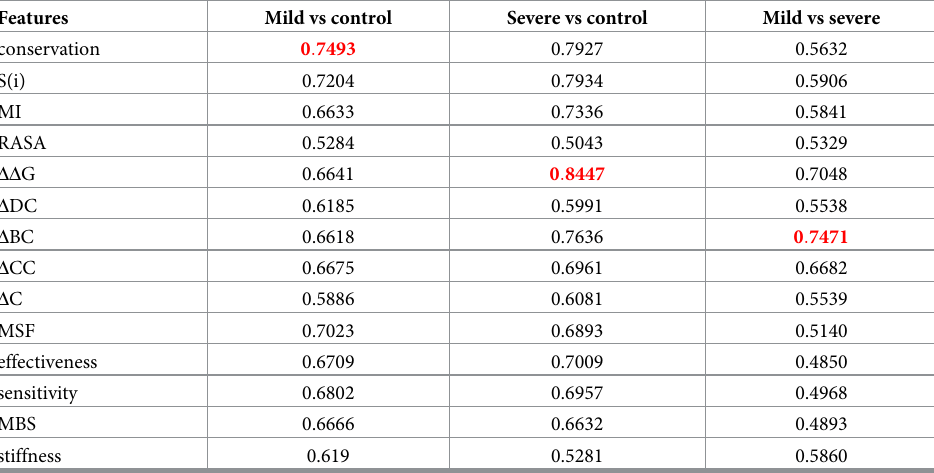
Table 2. The AUCs of 14 characteristics or parameters in each comparison group. The characteristics that per- formed best in each group are highlighted in red.